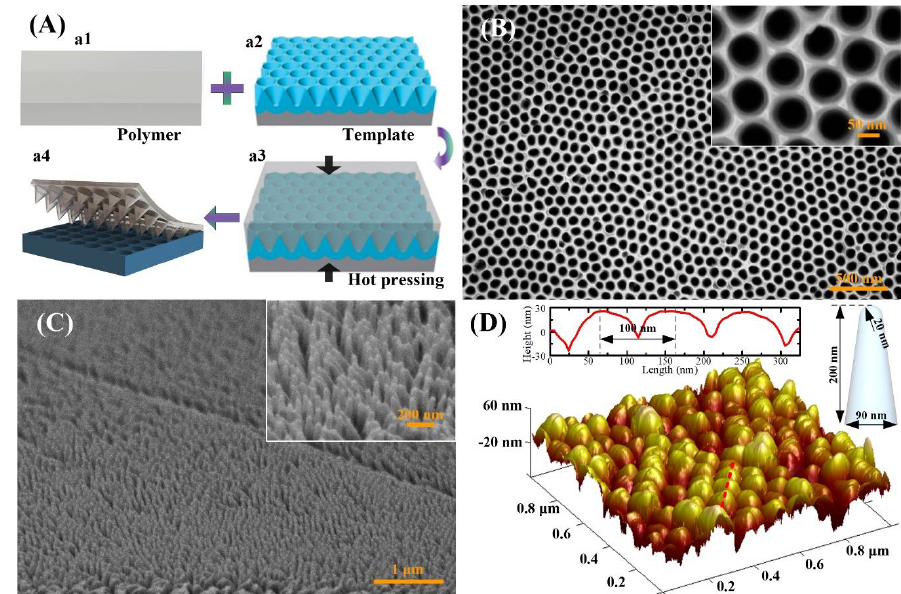
Figure 2. ( A ) Scheme of the fabrication processes for nanocone PVA film. ( a1 ) the prepared PVA